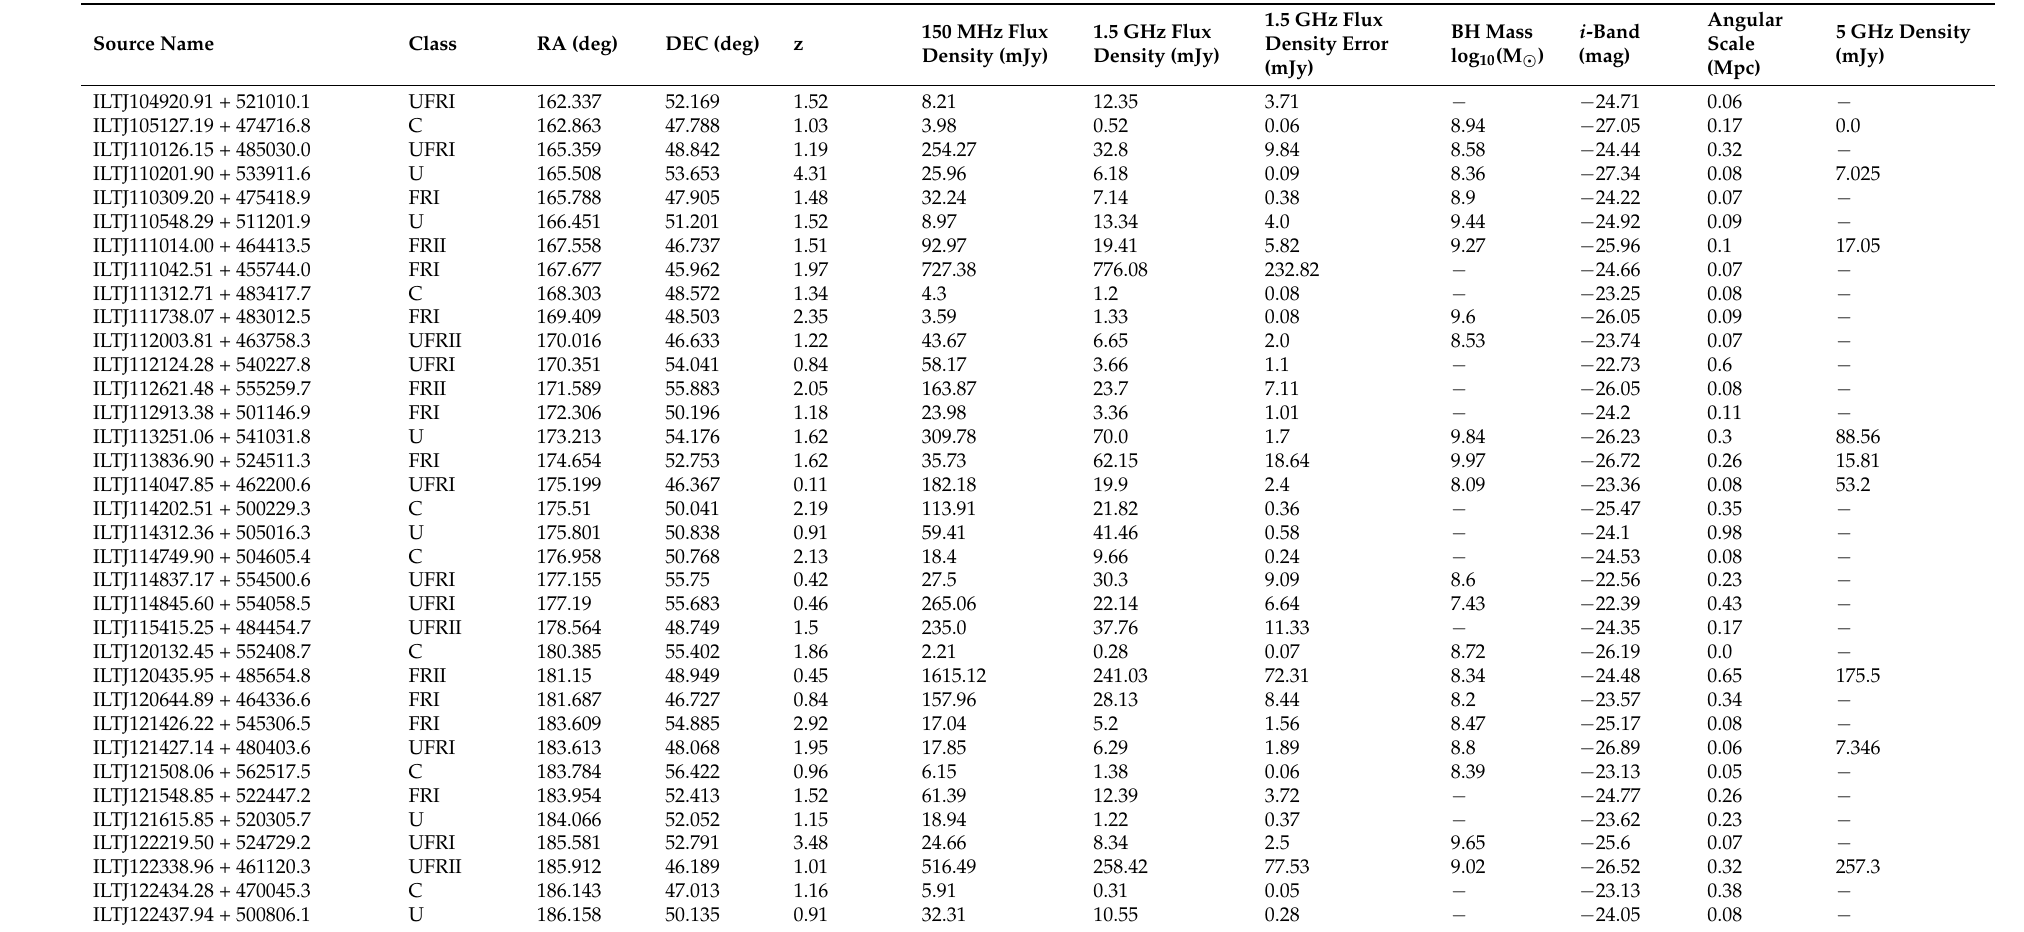
Table A1. Properties of our target sources that were observed as part of the VLA snapshot survey. Unique source name (column 1), radio morphological class (column 2), right ascension and declination (column 3 & 4), redshift (column 5), 150 MHz flux density (column 6), 1.5 GHz flux density and its error (column 7 & 8), black hole mass (column 9), SDSS i -band magnitude (column 10), physical angular scale (column 11) and 5 GHz flux density (column